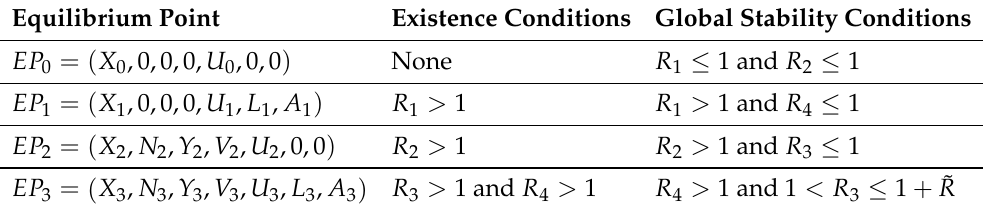
Table 1. Conditions of existence and global stability of the system’s equilibria. Equilibrium